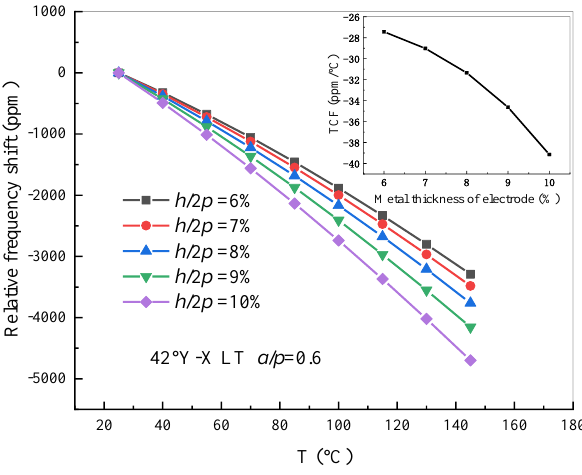
◦ Y-X LT with di ff erent electrode thicknesses.